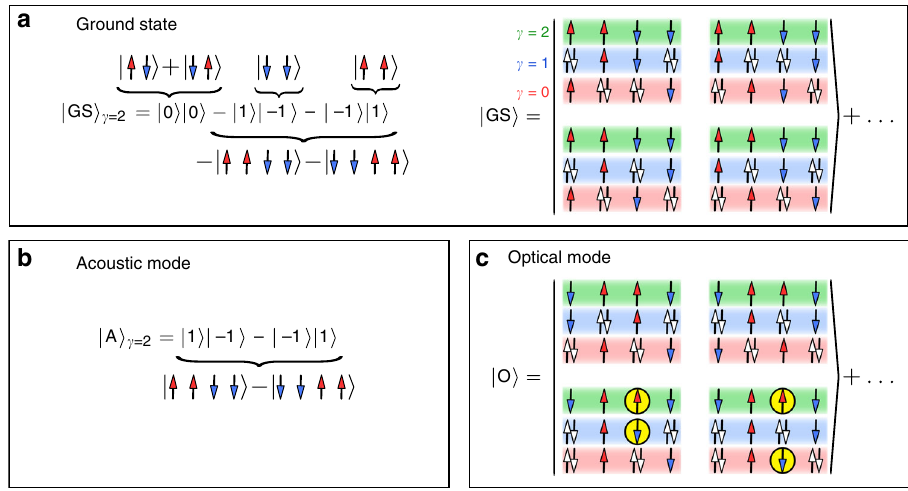
Fig. 4 States relevant for the dynamical SSF. Spin con fi guration in the localized orbital ( γ = 2) (see text for details) of the a GS j i (singlet) and b A j i state (triplet) contributing to the acoustic mode. c Schematic representation of particle con fi guration of all orbitals of the GS j i and optical triplet O j i . Circles represent pairs of antiferromagnetically aligned spins which break the Hund ’ s rule